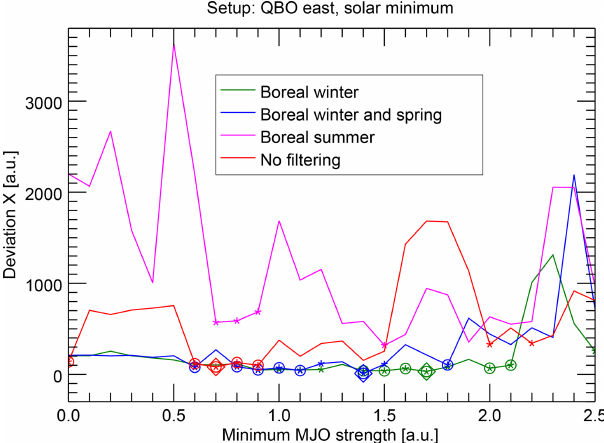
Figure 7. As in Fig. 5, but with seasonally resolved results. The green line corresponds directly to the green line in Fig. 5.